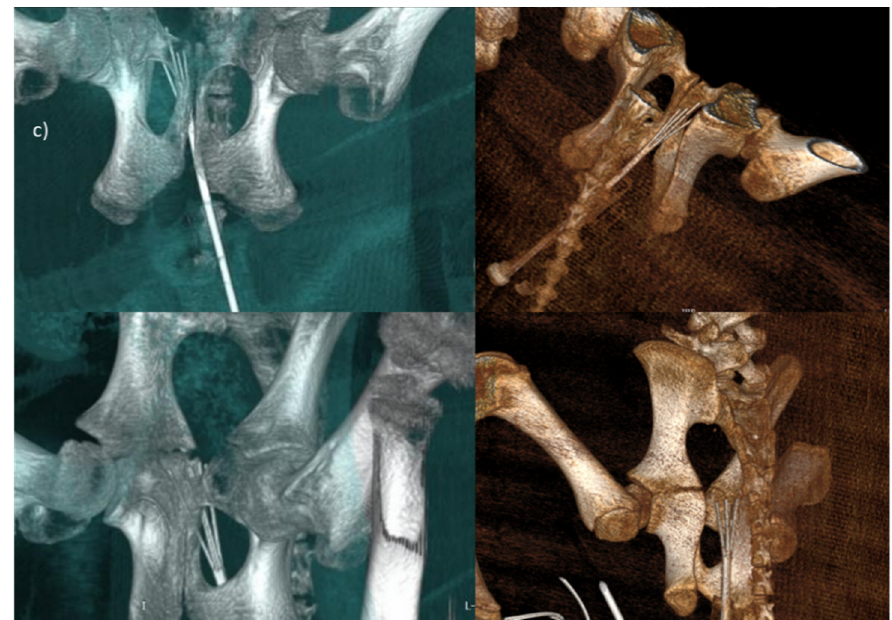
Figure 8. ( a ) Application on rectum with the trans-anal endoscopic procedure and the 5-needle expandable electrode (20° of divergence; ( b ) CT transversal sections in the two deployments: on the left, peripheral needles with exposure of 3 cm; on the right side, peripheral needles exposure of 4 cm; ( c ) volume rendering: in the top, deployment of central needle of 4 cm and peripheral needle exposure of 3 cm; down, central needle and peripheral needles exposure of 4 cm.